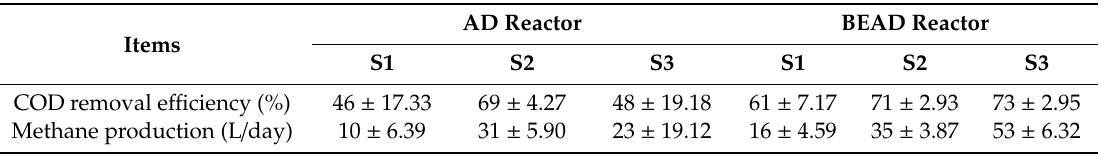
Table 2. Chemical oxygen demand (COD) removal e ffi ciency and methane production in AD and BEAD reactors at each OLRs stage.